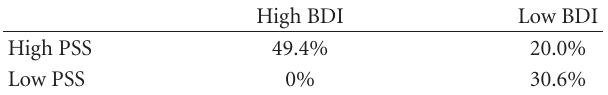
Table 1: Percentages of participants scoring high or low on the PSS (High = ≥ 11, Low = < 11) and on the BDI-II (High = ≥ 12, Low = <